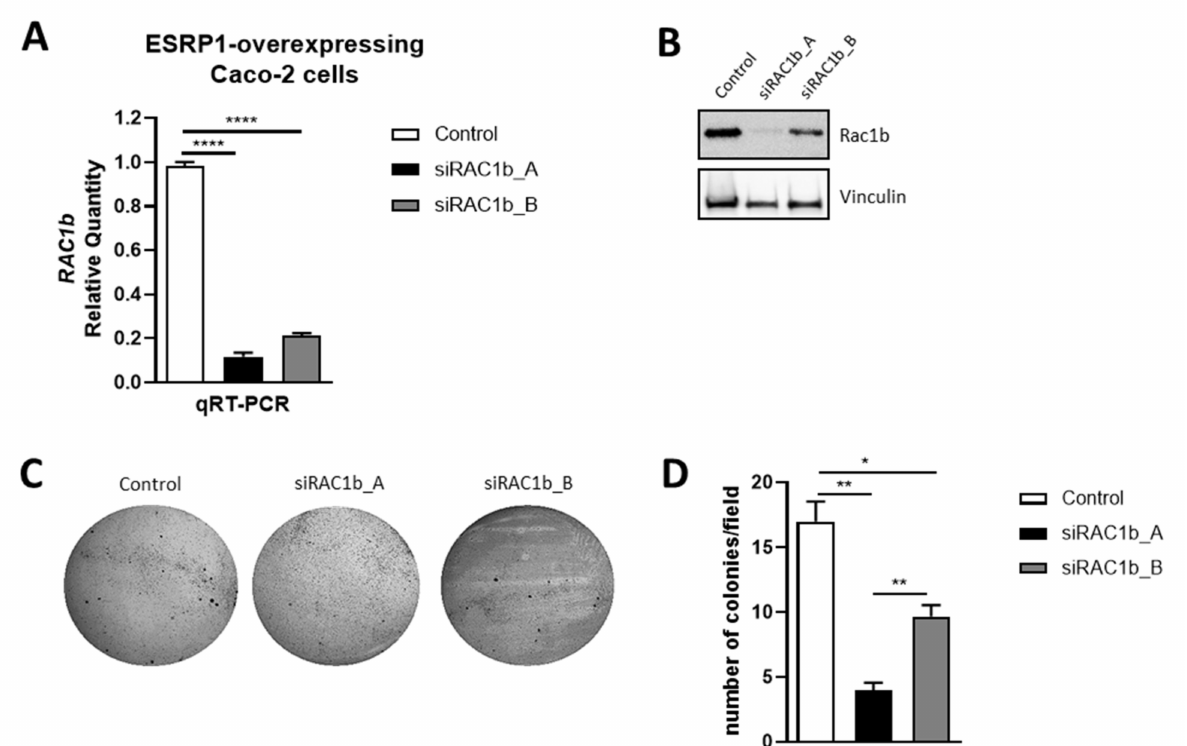
Figure 6. RAC1b silencing in ESRP1-overexpressing Caco-2 cells. ( A ) Gene expression levels of RAC1b in Caco-2 cells ( n = 3). Data are expressed as mean ± SEM of relative quantification using the delta–delta Ct method over IgG negative control, and normalized using GAPDH as housekeeping gene. Unpaired t-test was performed: **** p < 0.0001. ( B ) Western blot analysis of RAC1b in Caco-2 cells. ( C – D ). Soft agar assay. ( C ) Representative images and ( D ) quantification of colonies ( n = 3). Data are expressed as mean ± SEM. Unpaired t-test was performed: * p < 0.05, ** p <